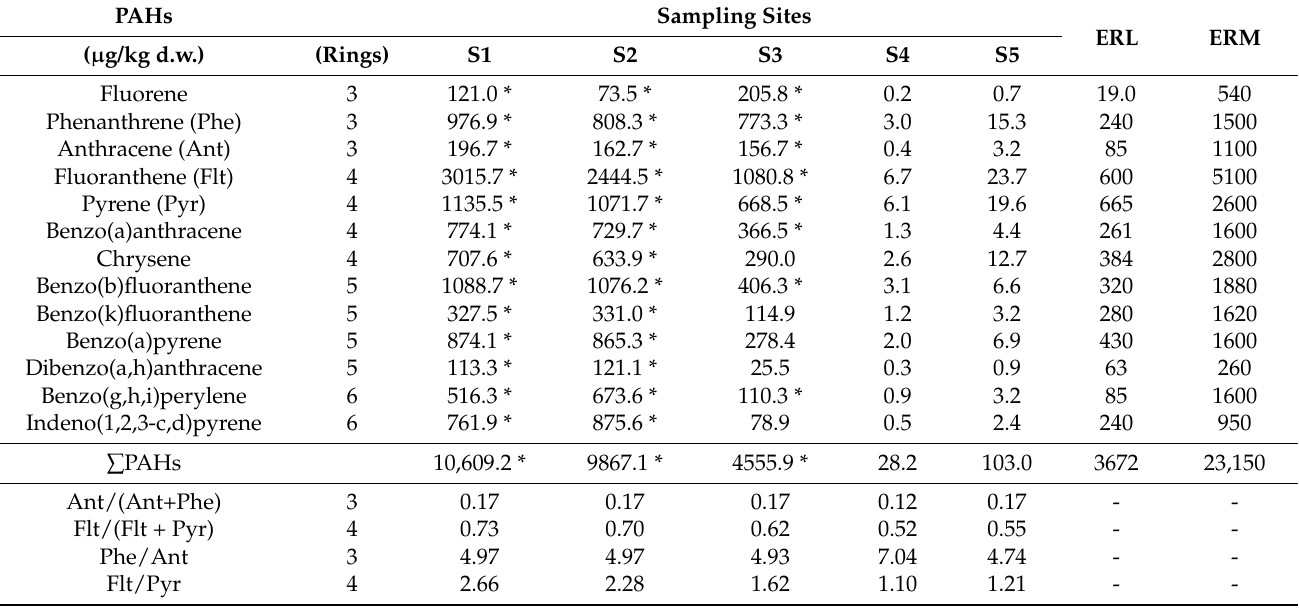
Table 1. Concentrations of PAHs and PAH ratios in sediments of investigated area with effect range low (ERL) and effect range median (ERM) values as a measure of